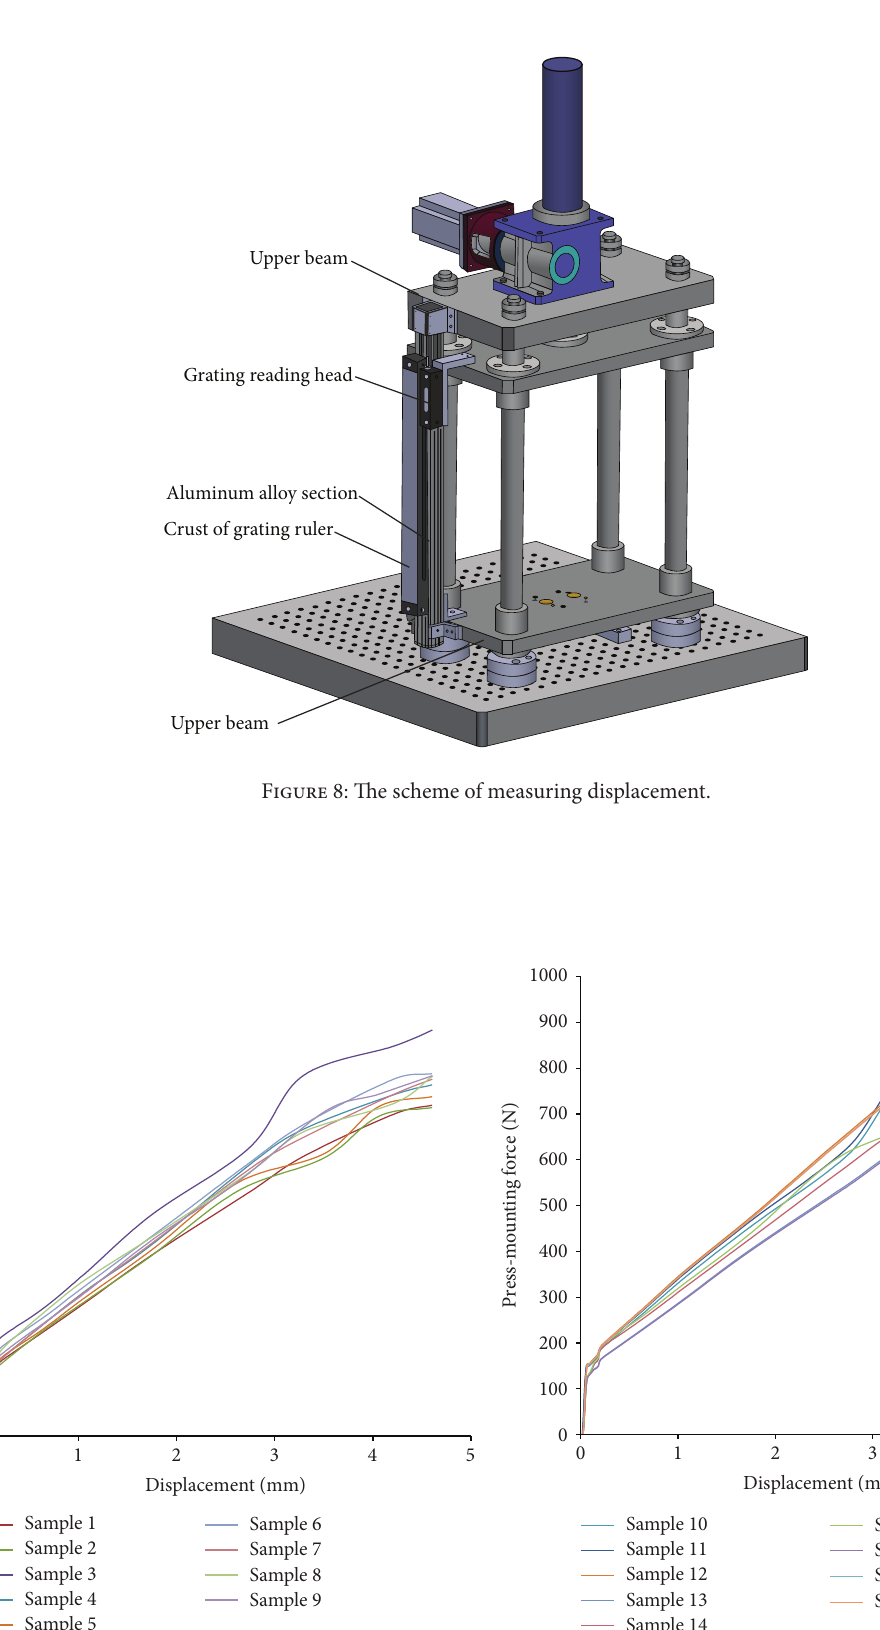
Figure 9: Press-fit curves obtained from the